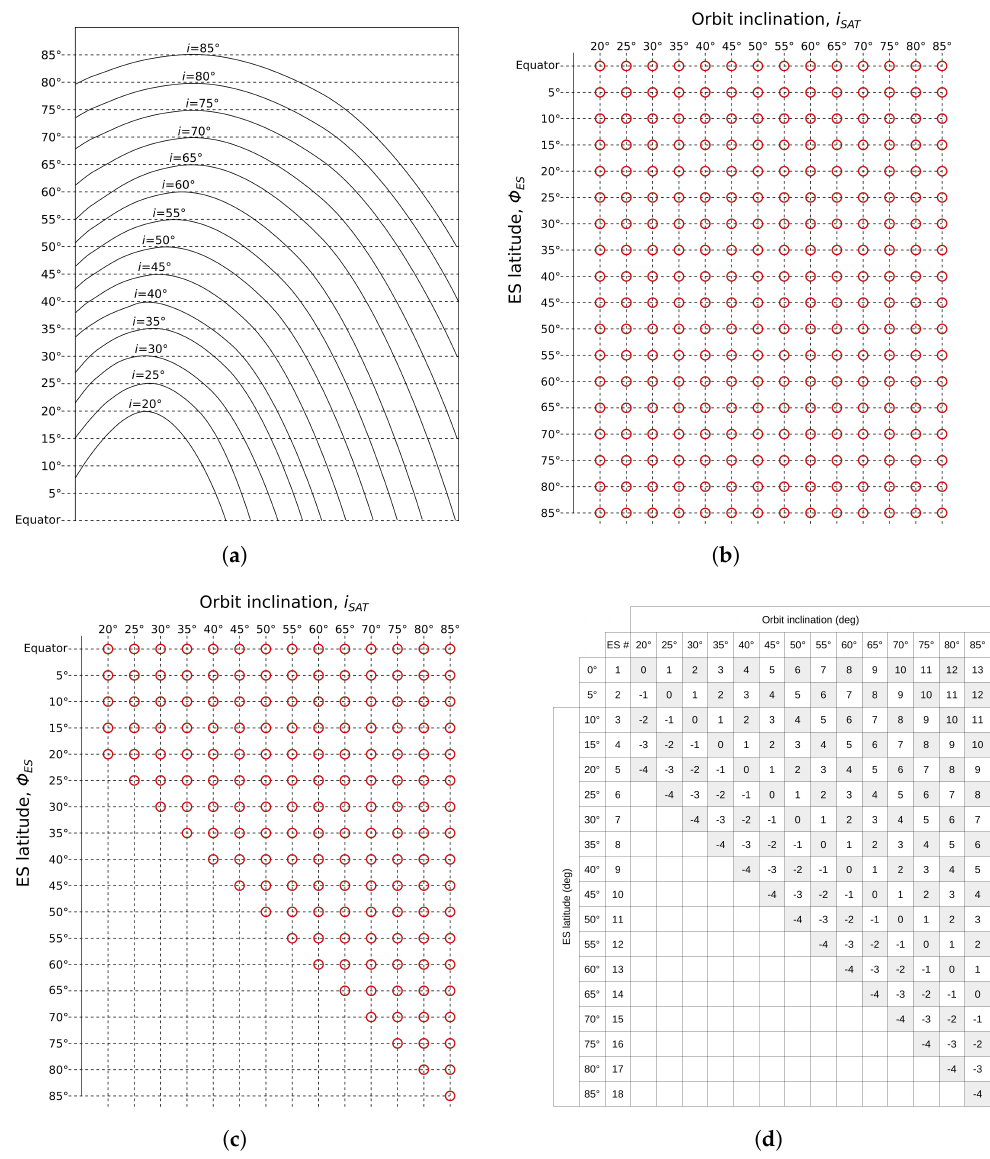
Figure 9. Simulated orbits: ( a ) Model without scale illustrating satellite passes at different orbit inclinations, i , over different ES’s latitudes. ( b ) Simulated orbit inclinations and ES’s latitudes as points in a grid. ( c ) Reduction of the grid showing in each column the ES’s below the simulated orbit inclinations. ( d ) Simulated points as diagonal elements within a